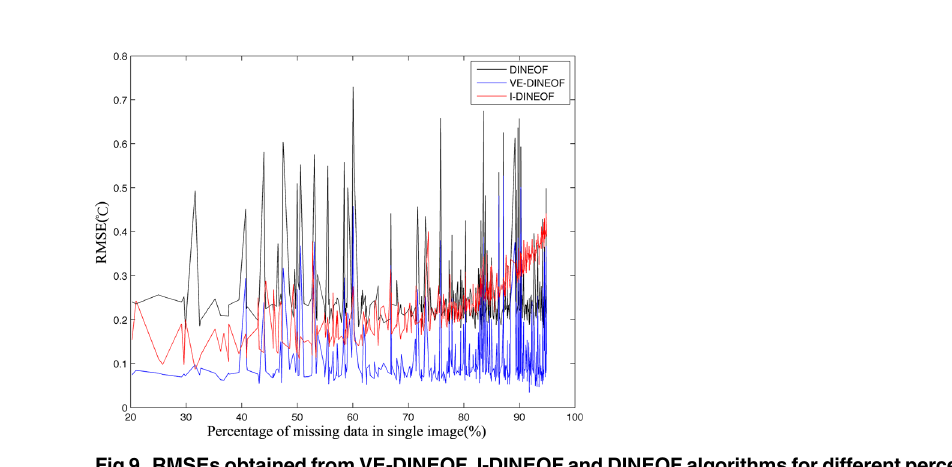
Fig 9. RMSEs obtained from VE-DINEOF, I-DINEOF and DINEOF algorithms for different percentages of missing